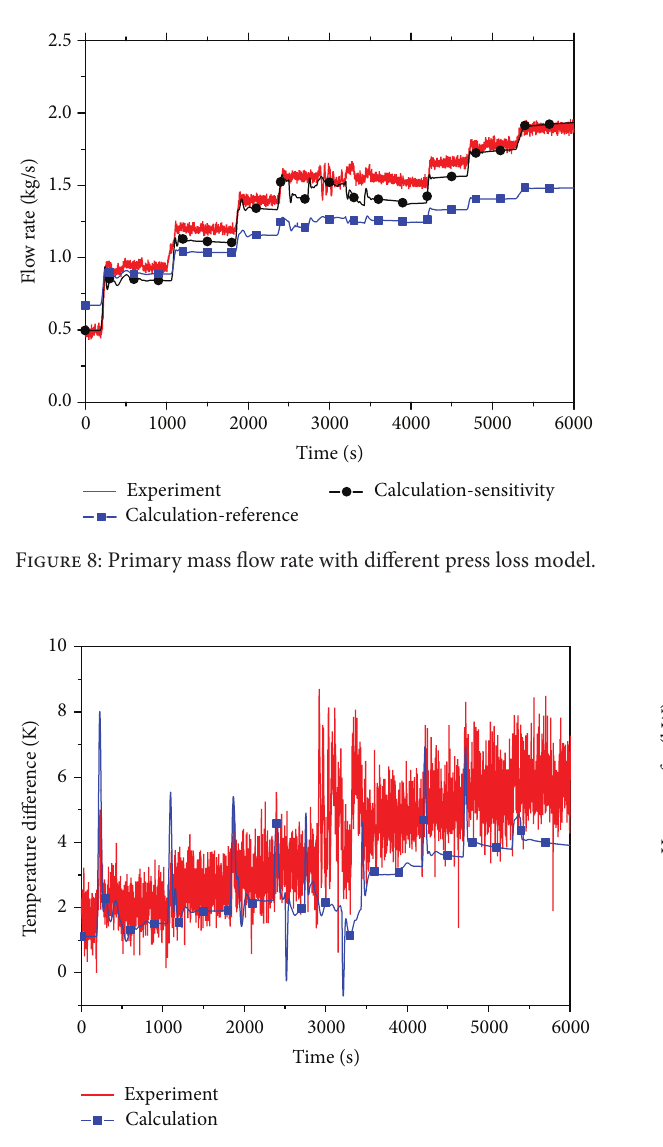
Figure 9: Temperature difference between the hot and cold sides.